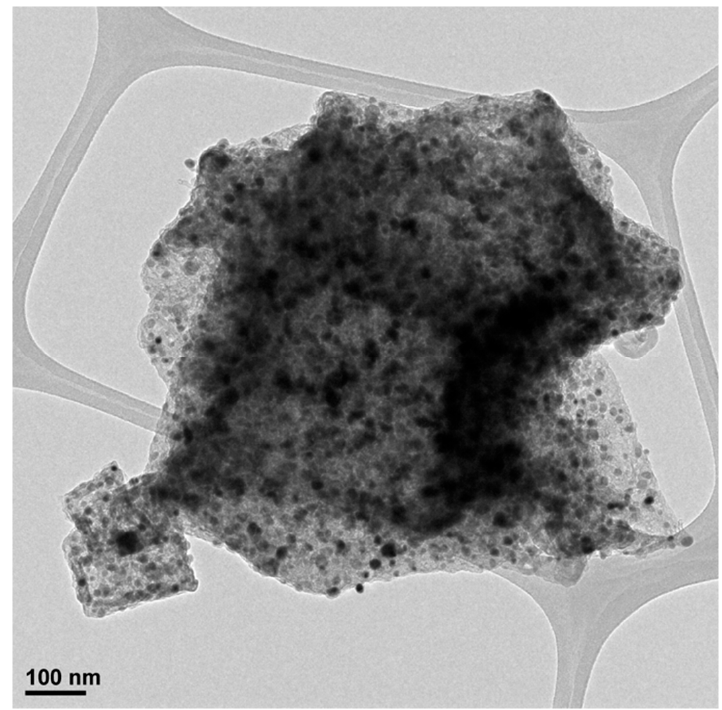
Figure A9. TEM micrograph of ZIF-67 carbonized at 700 °C.